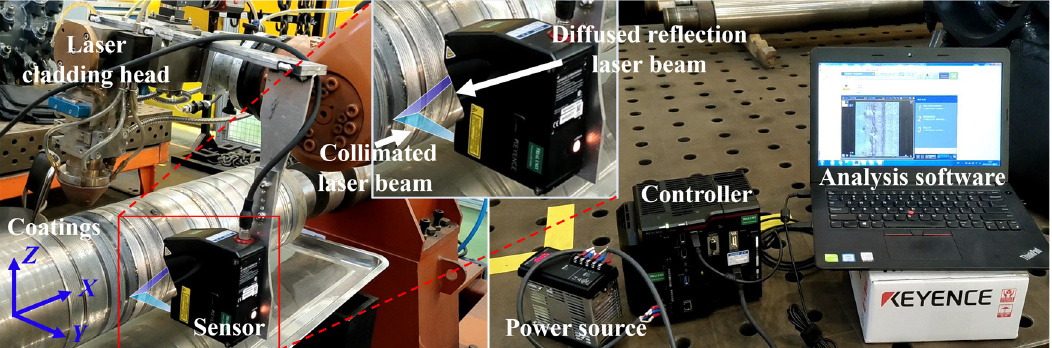
Figure 3. On-line monitoring system of forming quality of EHLA coating.